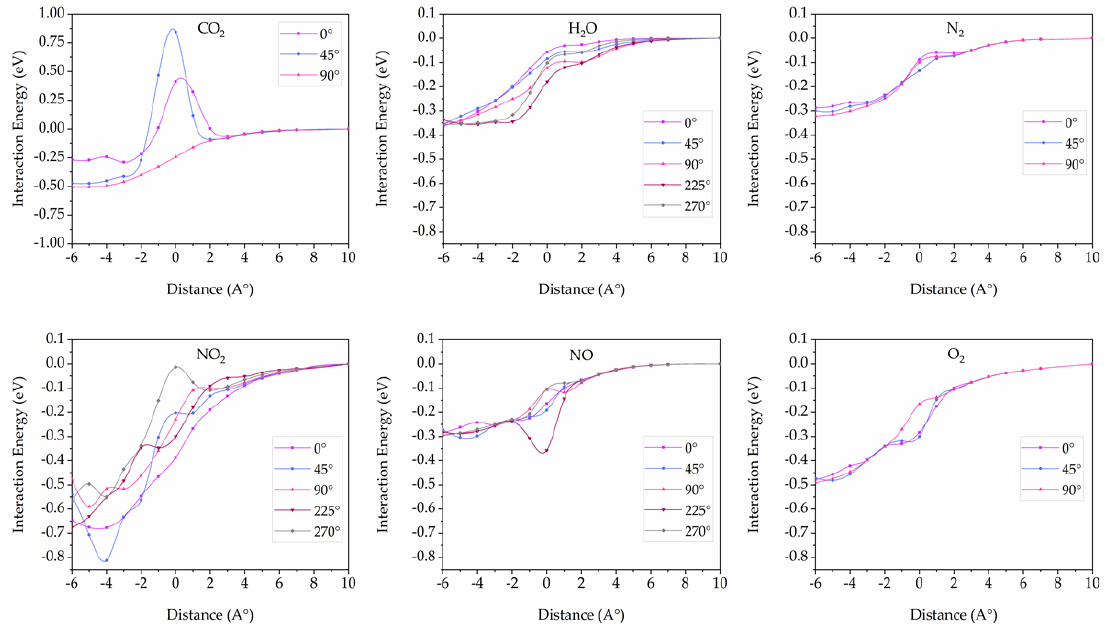
Figure 10. Interaction energies between 3D pillared SiC (5,5) nanostructures and gas molecules with various orientations as a function of distance.